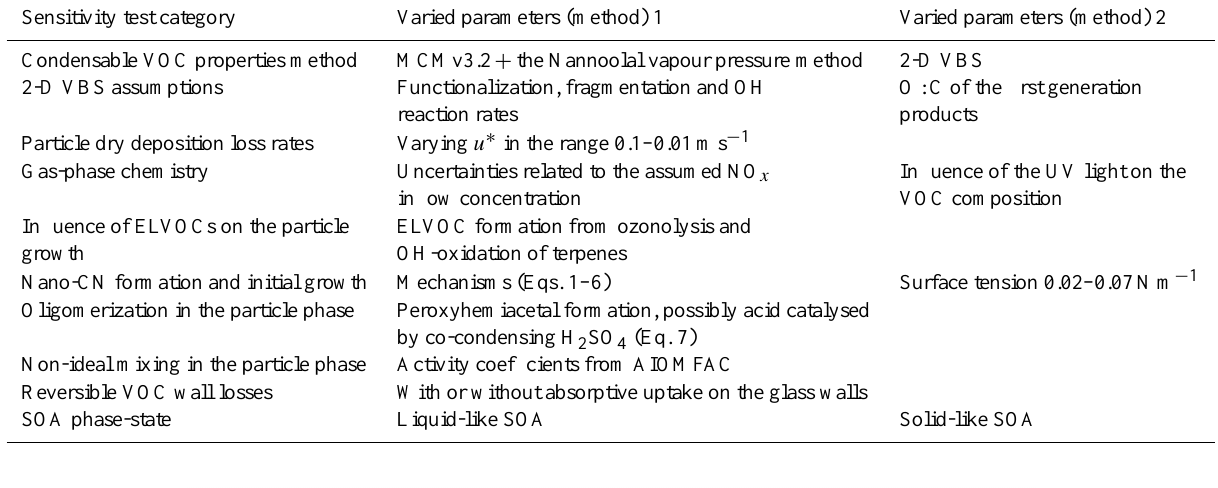
Table 2. Summary of the model sensitivity tests that we performed in order to evaluate and constrain possible mechanisms for the formation and growth of nano-CN during the JPAC experiments.